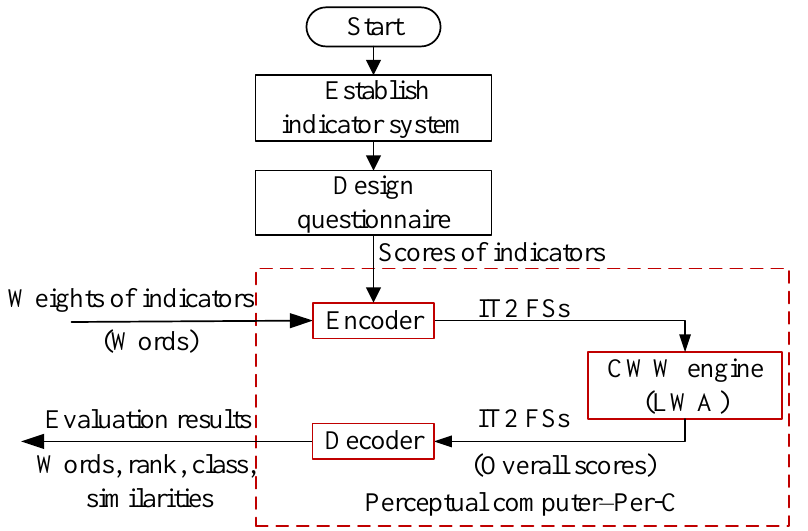
Figure 1. Flow chart of the proposed university teachers teaching performance evaluation approach based on T2 FSs and the Per-C method.